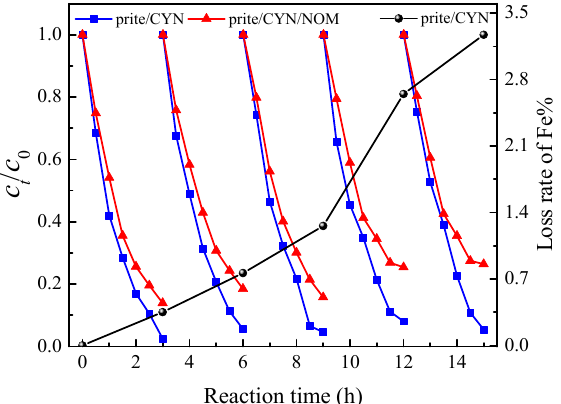
Figure 3. Results of recycling degradation. CYN concentration = 2 mg/L; humic acid (HA) concentration = 20 mg/L; pyrite dose = 0.5 g/L; no pH adjustment.